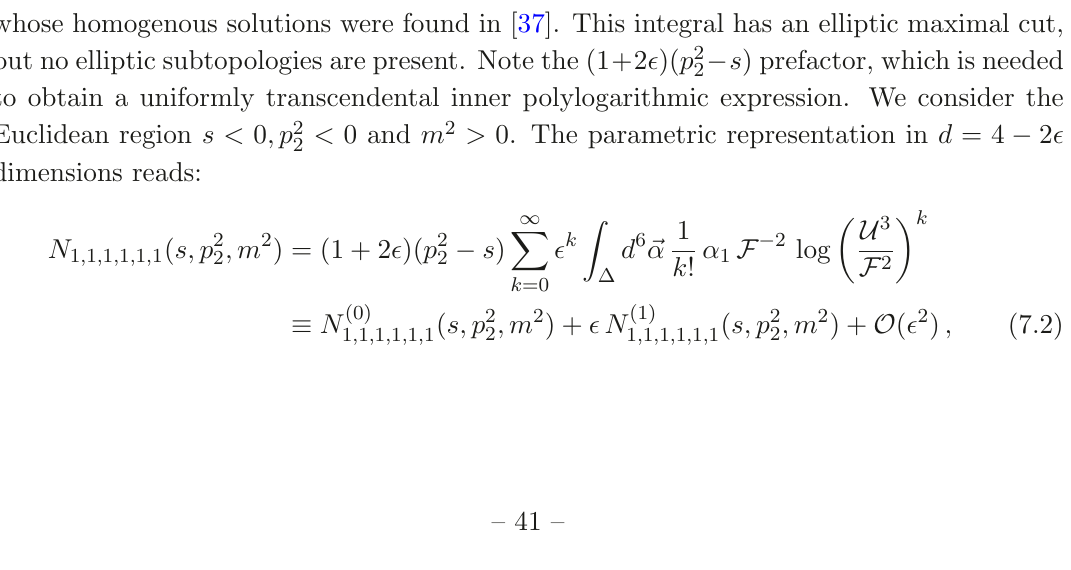
Figure 2 . Plots of the first two epsilon orders of T